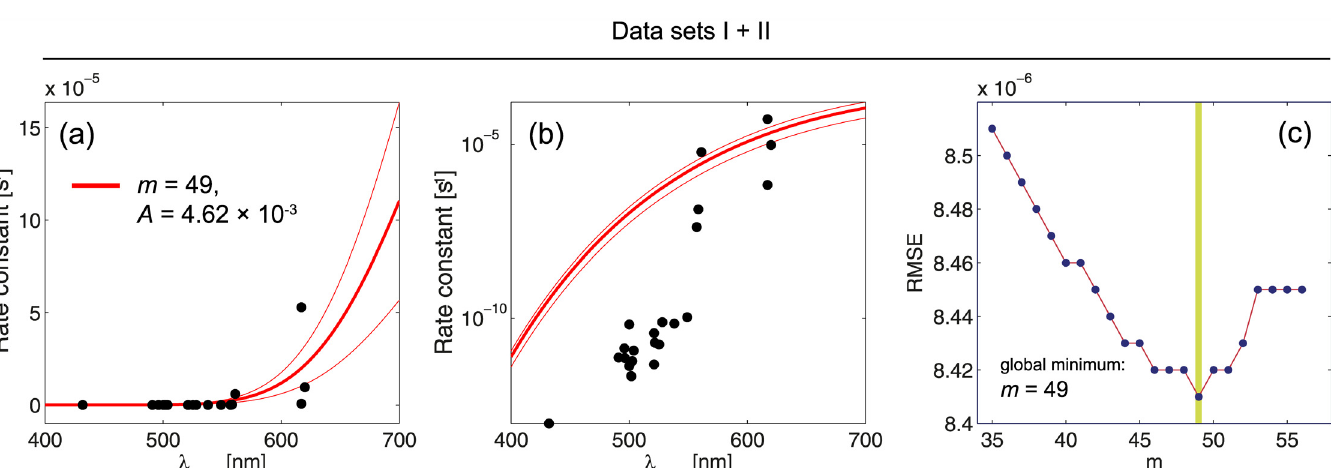
PLOS ONE | DOI:10.1371/journal.pone.0148336 March 7,